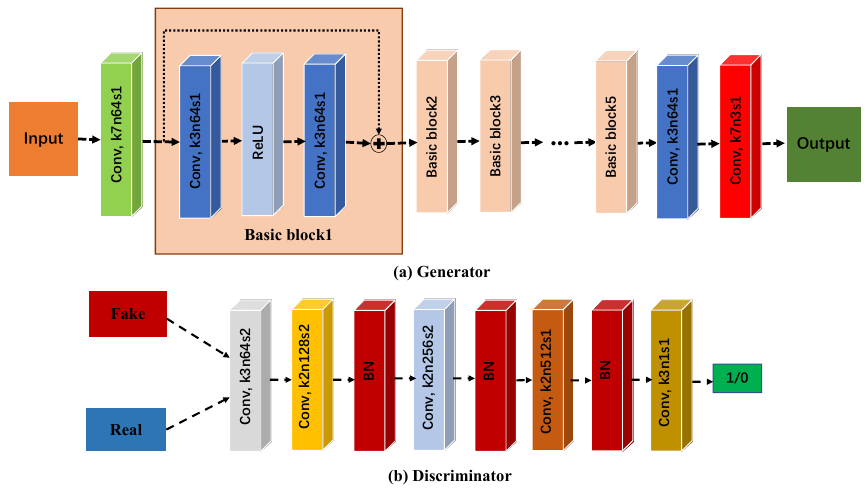
Figure 3. The architecture of generators and discriminators in this